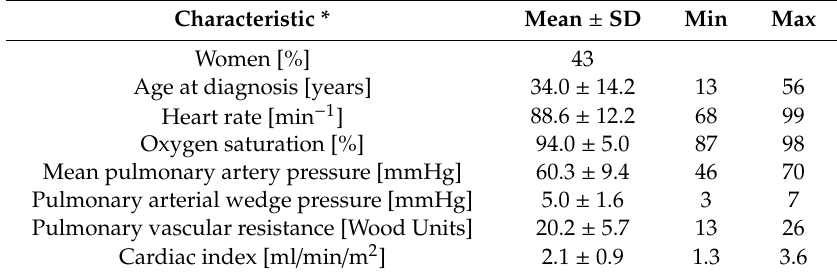
Table 1. Clinical characteristics of the index patients from the seven HPAH families at initial diagnosis.